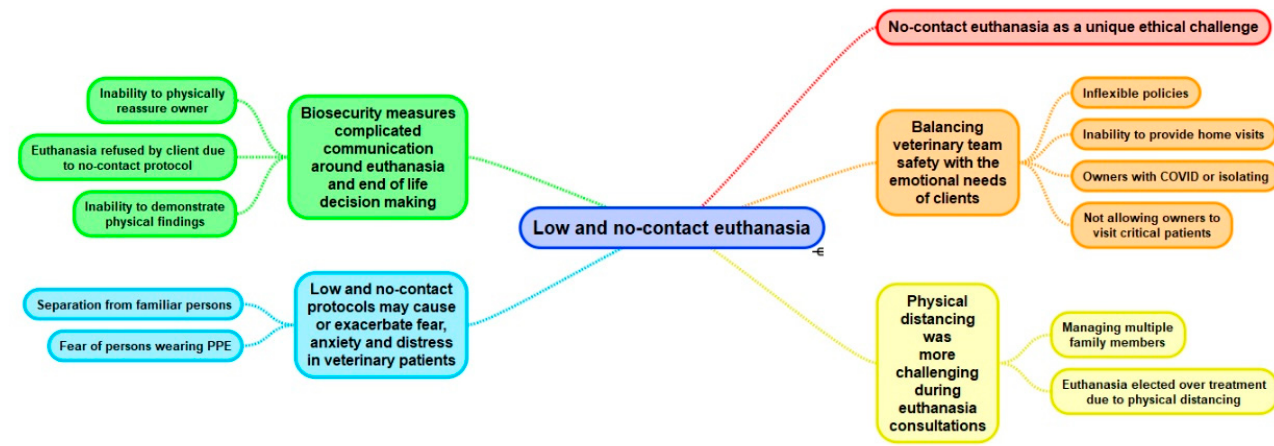
Figure 1. Thematic map depicting themes and subthemes constructed through reflexive thematic analysis.